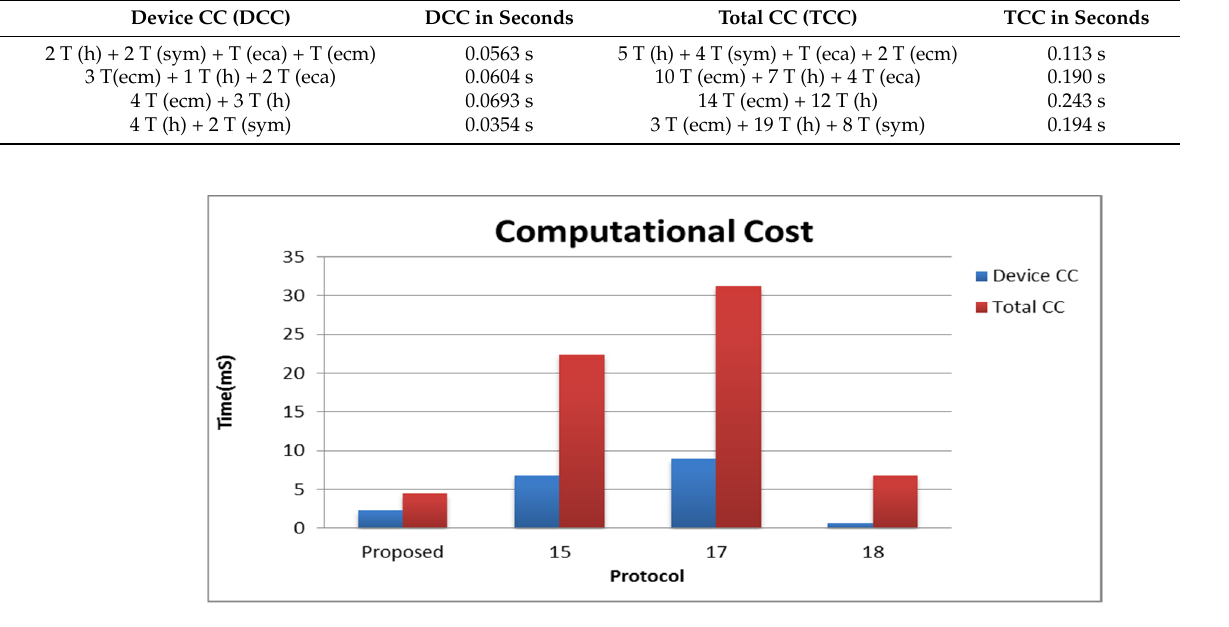
Figure 11. Computational cost comparison.